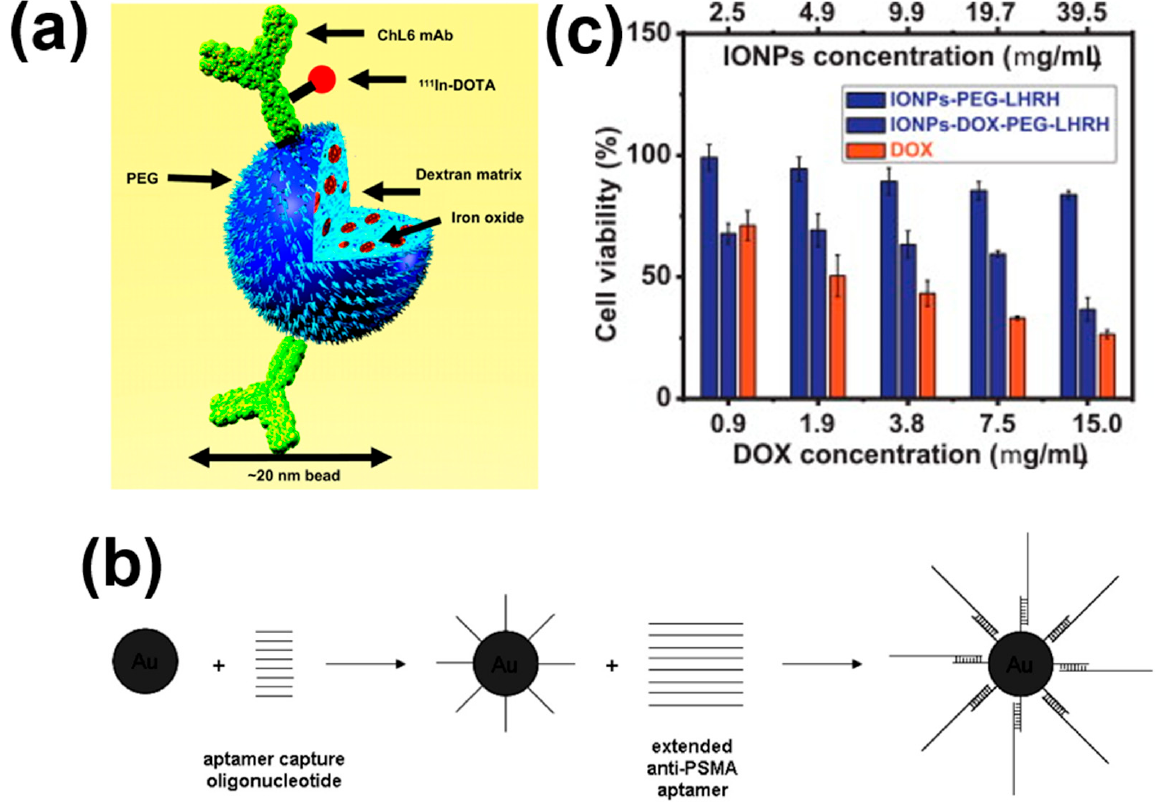
Figure 3. ( a ) Schematic diagram for the conjugation of ChL6 antibody with MNPs. Reprinted with permission from [108]. Copyright 2007 SNMMI. ( b ) Schematic representation for the conjugation of anti-PSMA aptamers with gold nanoparticles. Reprinted with permission from [31]. Copyright 2008 American Chemical Society. ( c ) The cell viability of A2780/AD human ovarian cancer cells using a DOX, IONPs-DOX-PEG-LHRH, and DOX loaded IONPs-DOX-PEG-LHRH system. Reprinted with permission from [34]. Copyright 2013 Elsevier B.V.